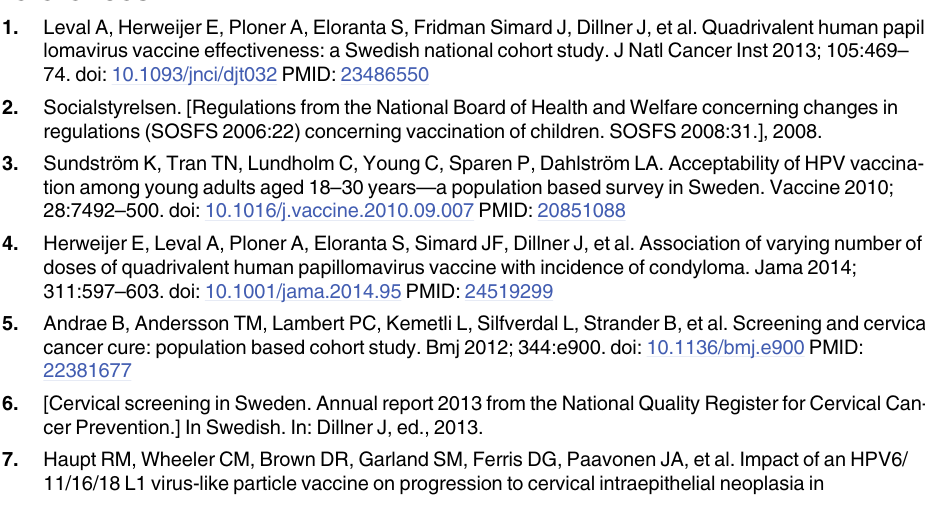
S1 Fig. Flow chart over the women not invited to screening during the study period, by explanation. S2 Fig. Screening attendance after date of invitation by vaccination status and education level. S1 Table. Adjusted hazard ratios of screening attendance to two consecutive screening rounds in HPV-vaccinated women compared to unvaccinated women. S2 Table. Adjusted hazard ratios of screening attendance in HPV-vaccinated women com- pared to unvaccinated women during the entire study period, and by round 1 and 2 during follow-up. S3 Table. Adjusted hazard ratios of screening attendance in HPV-vaccinated women com- pared to unvaccinated women for screening round 1 using various time